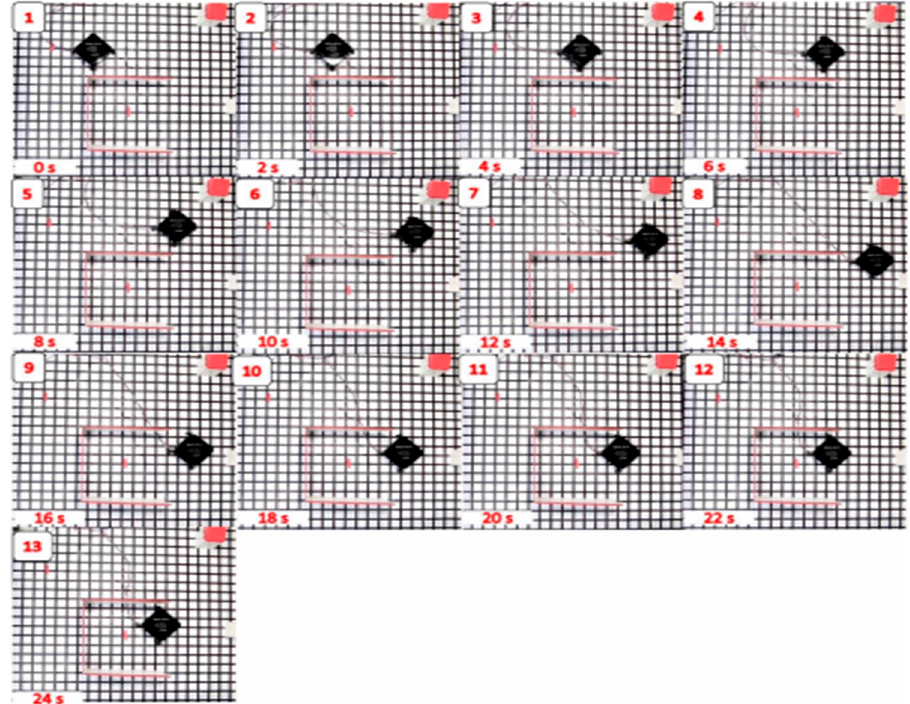
Figure 13. Screenshots for the experimental implementation of the Hybrid A* algorithm on the 4OWMR for Map2.